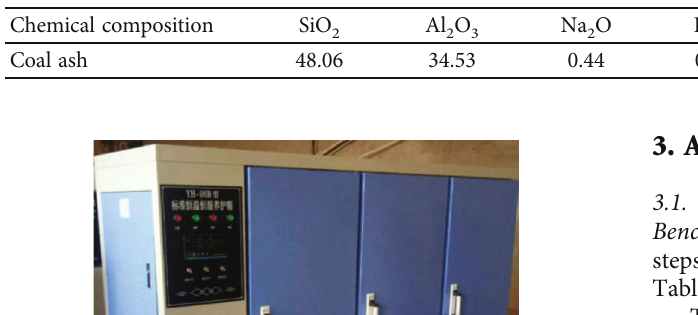
Table 2: Main chemical composition of coal